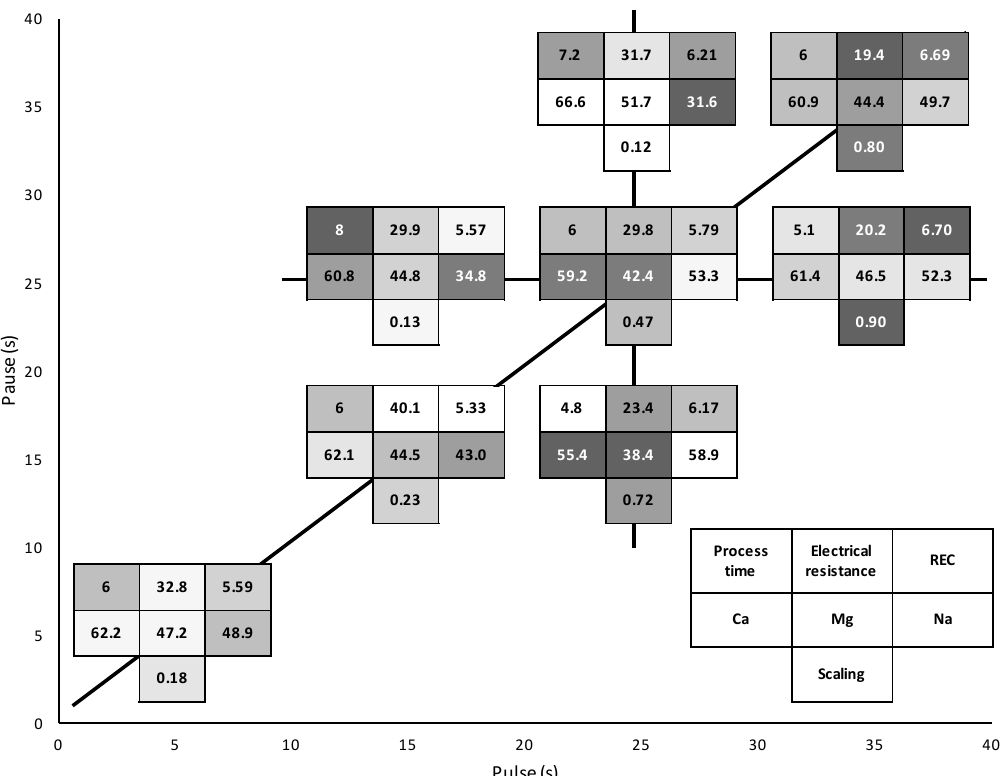
Figure 12. Schematic representation of the studied surface area comprised in the eight PEF conditions tested. Each condition is represented by a table including in the first row: its process duration (in h), its final electrical resistance reduction from the CC application results reported by [13] (in %), and its relative energy consumption (in Wh / g of lactic acid removed). The second row includes the demineralization rates of calcium, magnesium, and sodium (in %), while the third row reports the amount of scaling on the AEMs (in g / 100 g of dry membrane). The shades of grey represent the position of the condition among the others: the lighter the grey, the better the result in term of acid whey